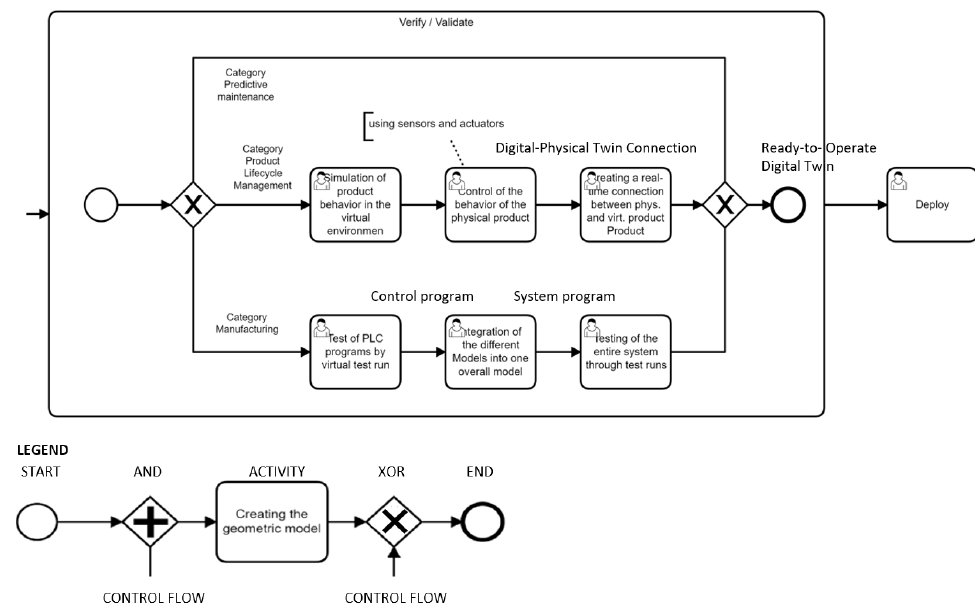
Figure 11. ‘Verify/Validate and Deploy’ subprocess of the integrated DT development model .